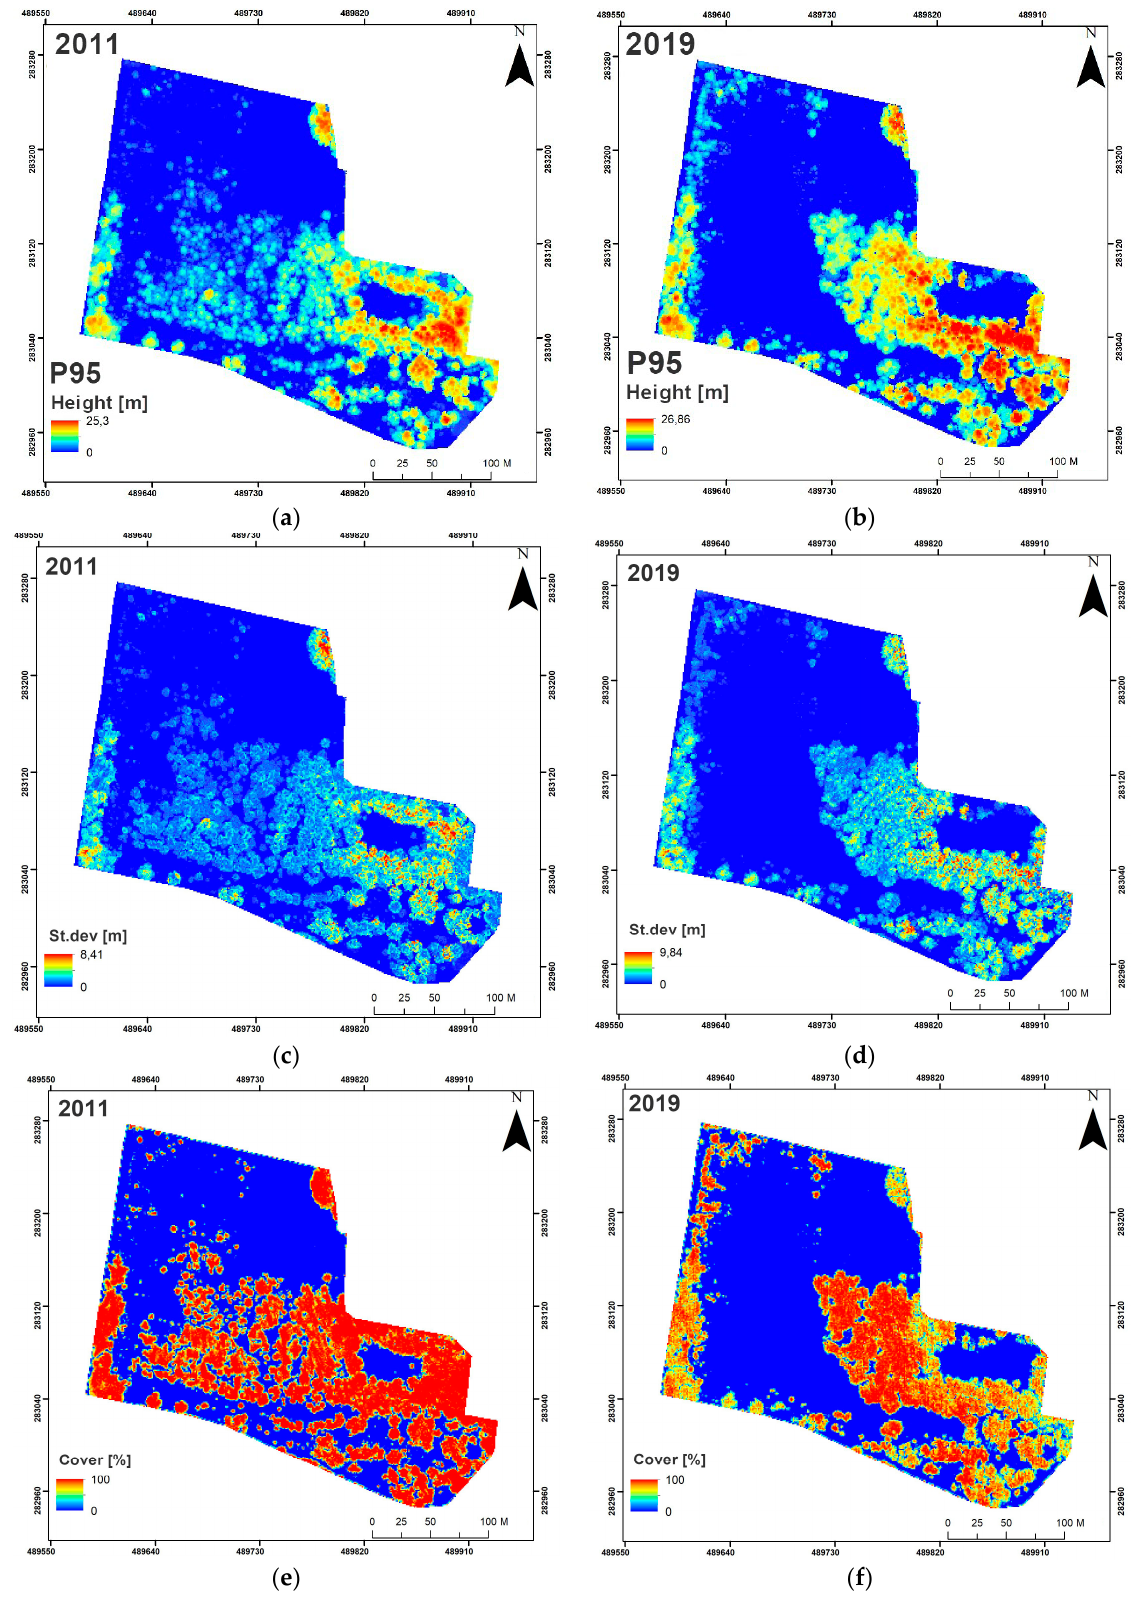
Figure 7. The results of the LiDAR point cloud (2011, 2019) processing: ( a , b ) vegetation height (95th percentile, P95); ( c , d ) standard deviation of height; ( e , f ) canopy cover (0–100%).